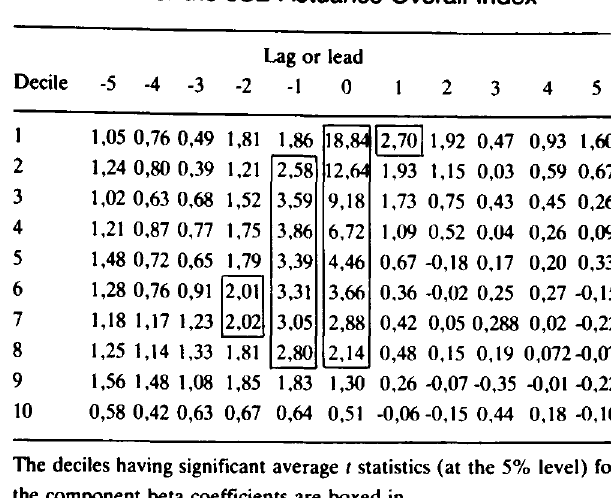
Table 2 average t statistics of the component